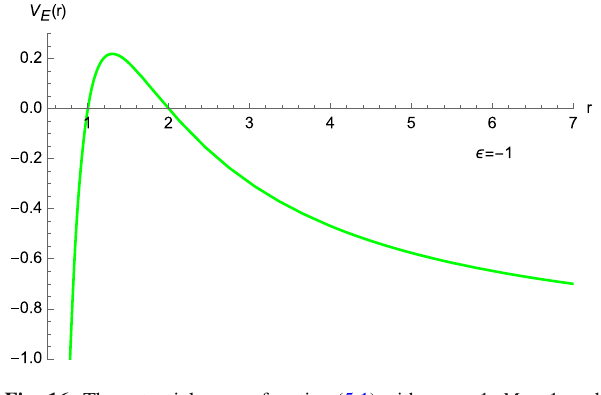
Fig. 16 The potential energy function (5.1) with ε = − 1, M = 1, and L = 1